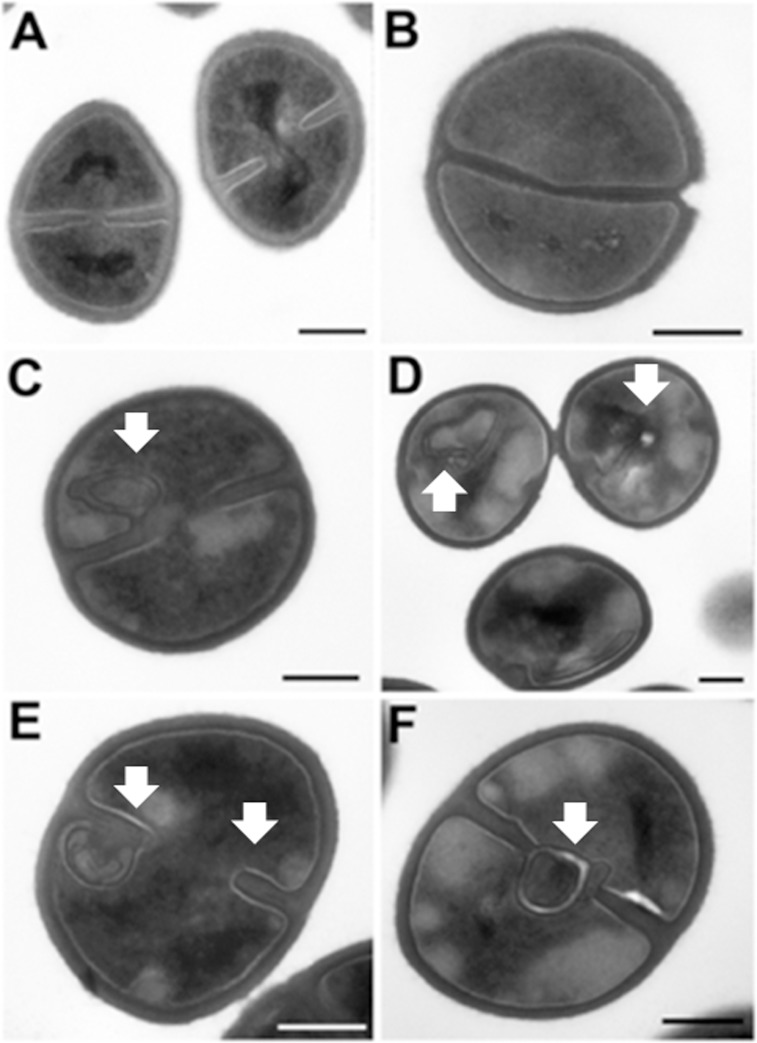
Effect of kendomycin on the cell division in S. aureus COL.Electron microscopic images of healthy control cells (A, B) and kendomycin treated cells (C-F). (A) Dividing control cells at the mid of septum formation. (B) Dividing cells with a completed septum. (C-F)Kendomycin treated cells exhibiting irregular septum morphologies. Bar = 200 nm.